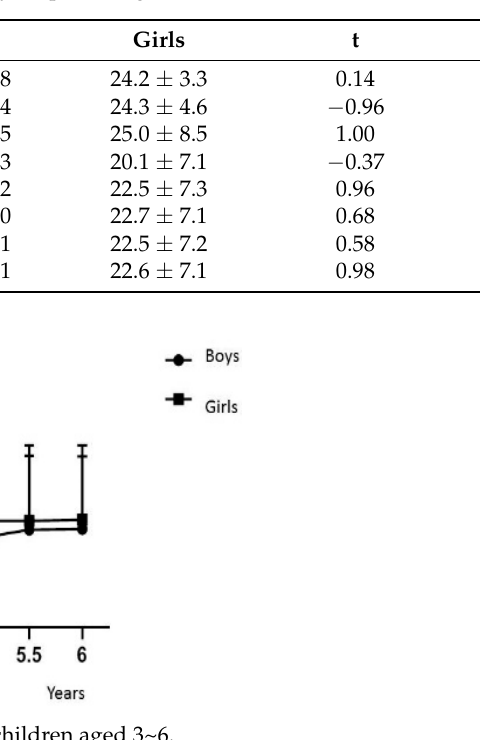
Table 7. Gender difference in body fat percentage ( X ± SD, %).